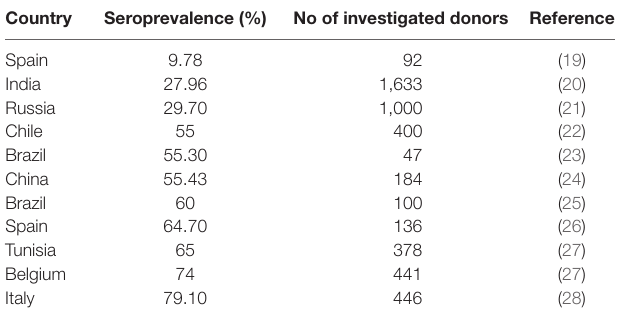
TaBLe 2 | Prevalence of parvovirus B19 (B19V) DNA in blood donations. Country